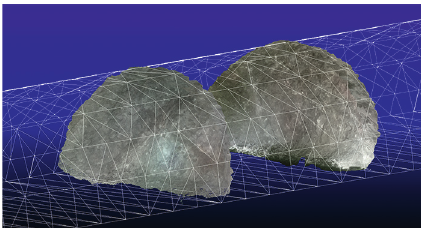
Figure 15: The results of 3D reconstruction in No. 1 Xinan railway tunnel in